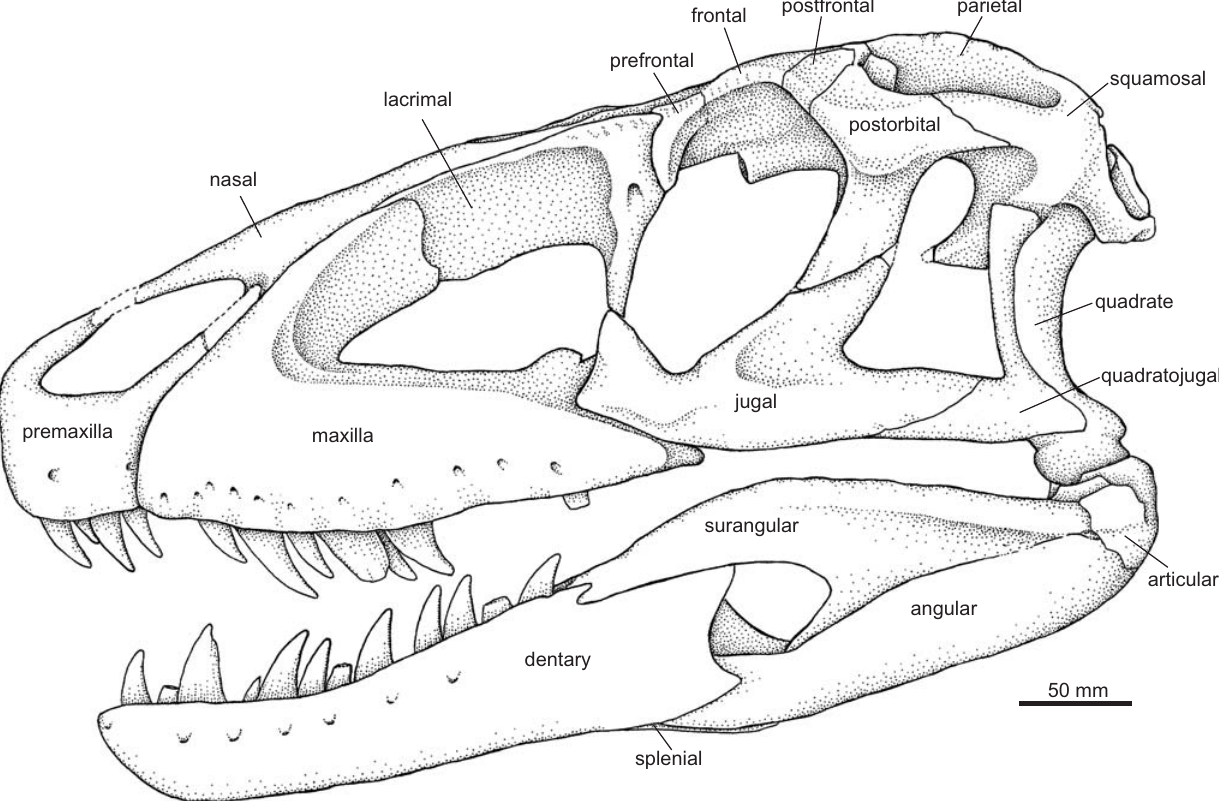
Fig. 20. Reconstruction of the pseudosuchian archosaur Prestosuchus chiniquensis Huene, 1938 (UFRGS-PV-0629-T) from the Dinodontosaurus Assemblage Zone, Ladinian, Middle Triassic, Dona Francisca municipality, Rio Grande do Sul State, Brazil; skull in lateral view.